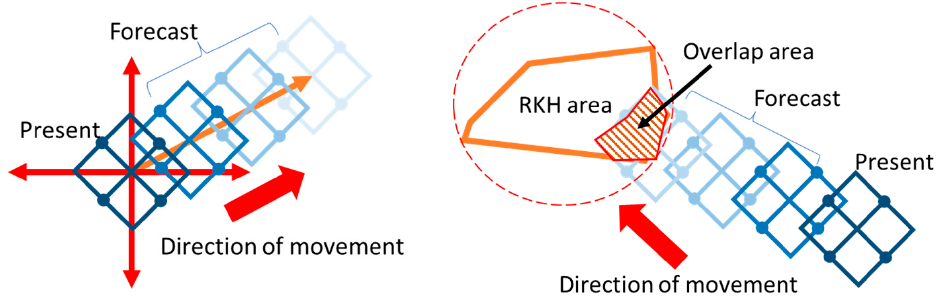
Figure 5. Schematics of forecasting the storm movements.